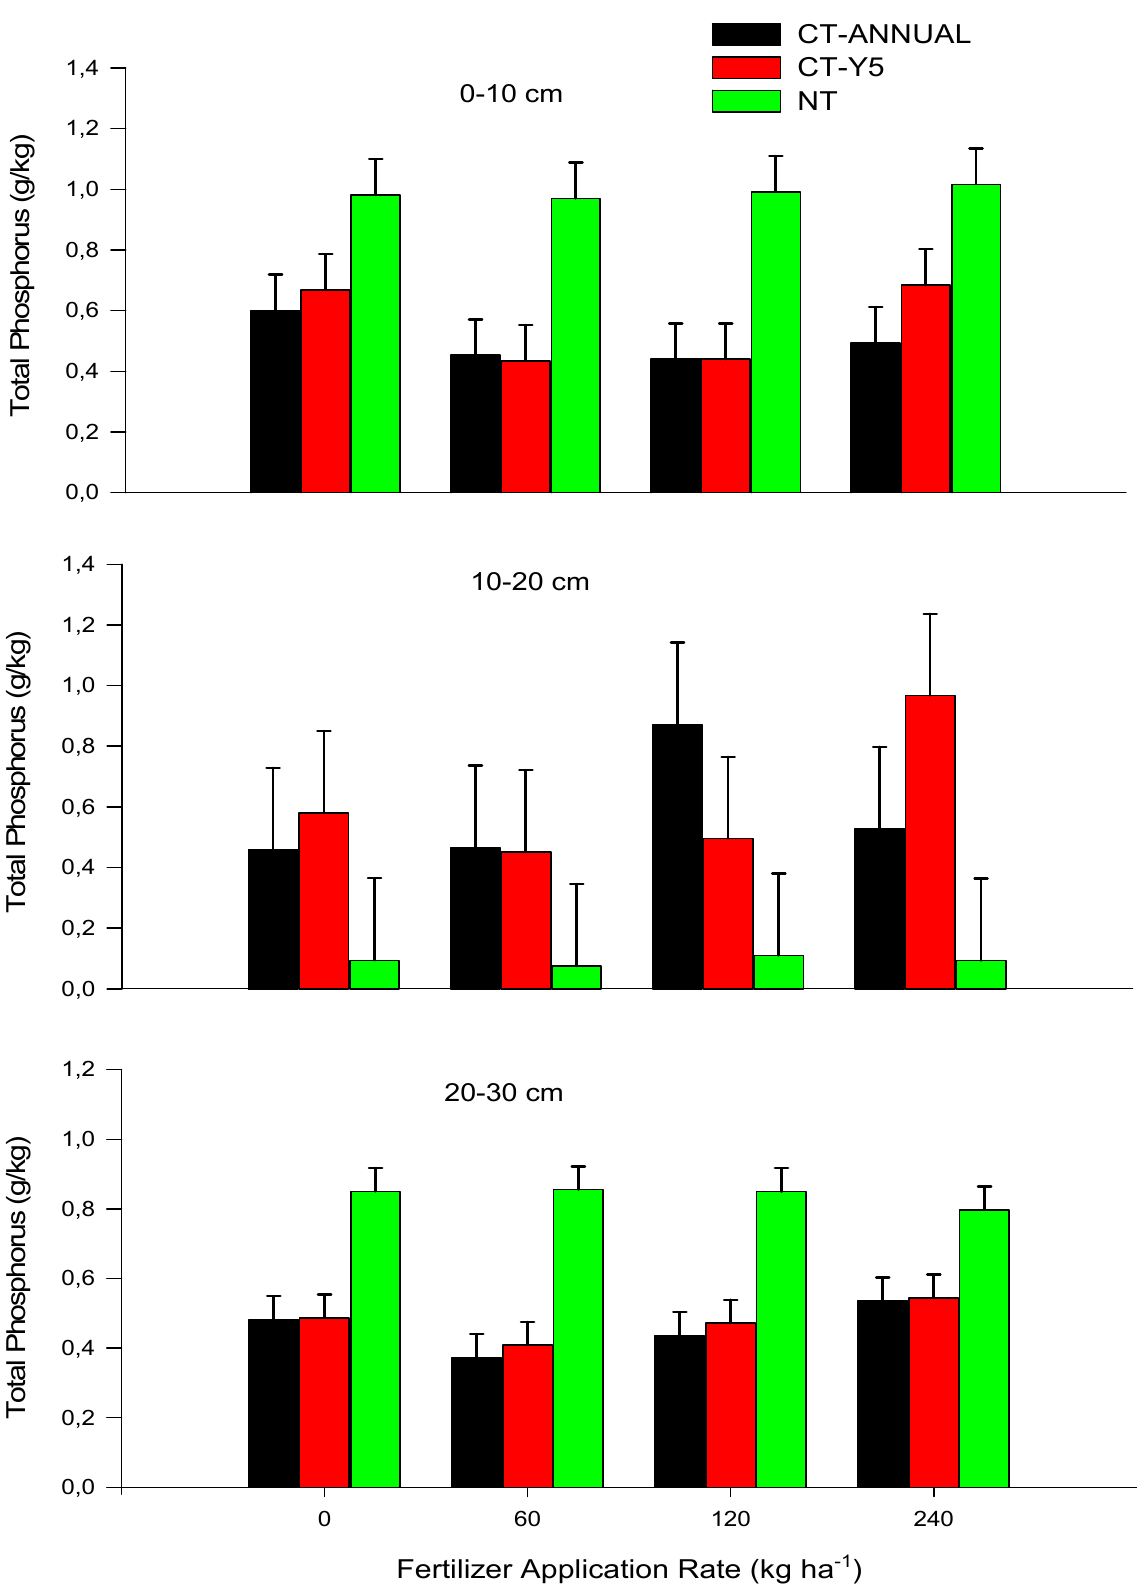
Figure 5. Contents of total P according to depth under different tillage techniques and urea fertilizer application rates.